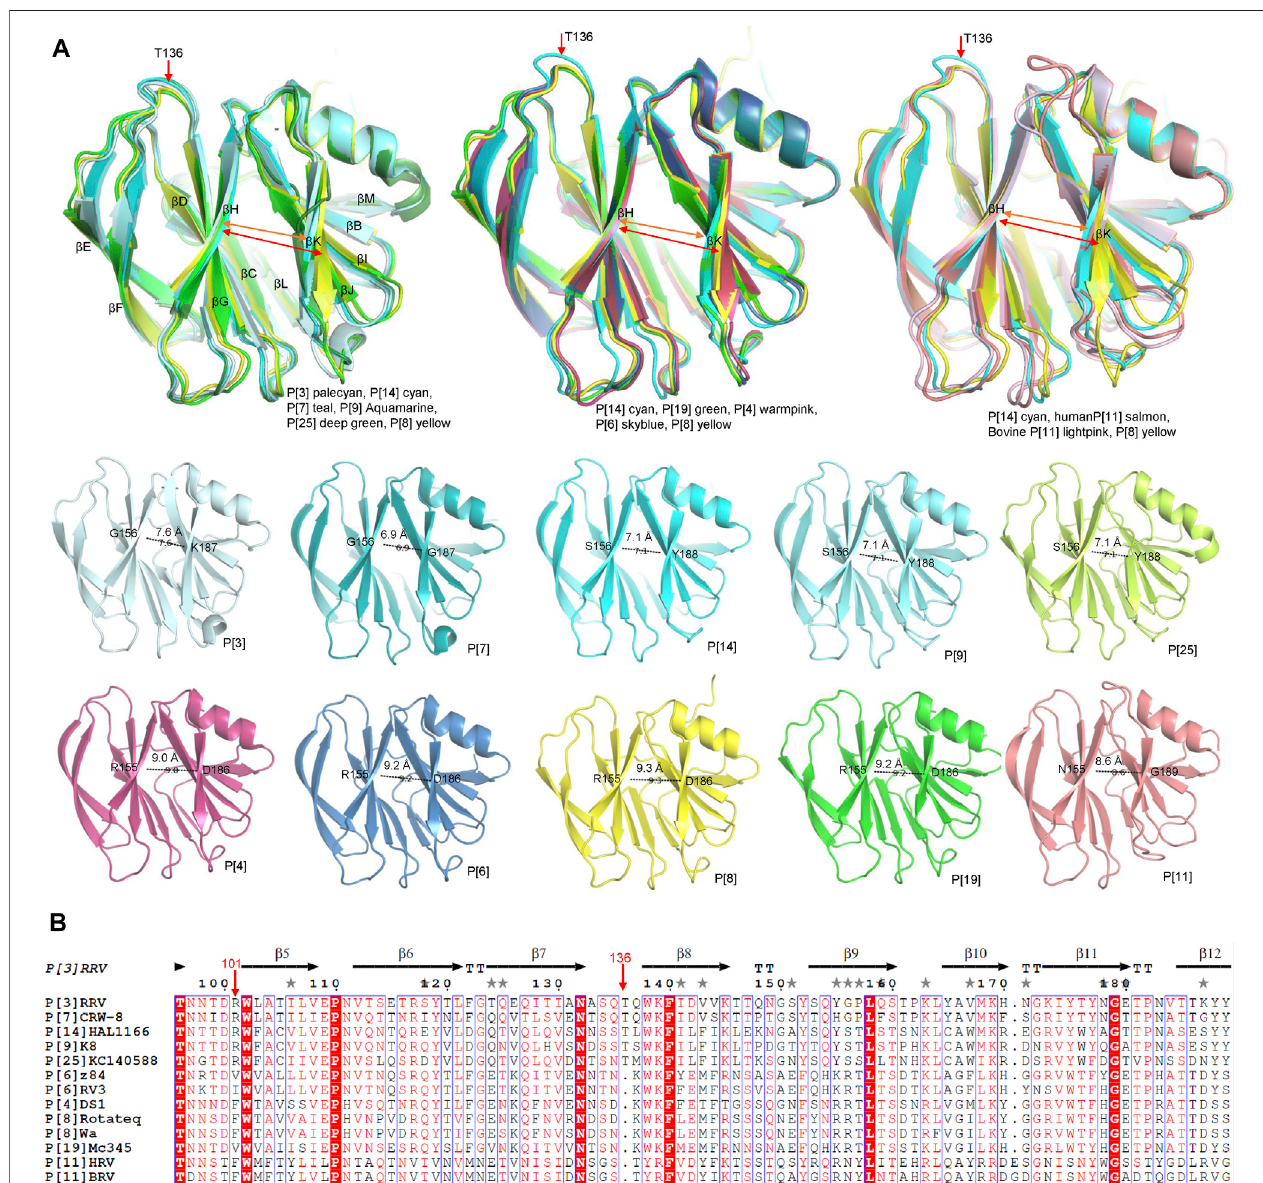
FIGURE 3 | (A) Structural analysis of the VP8* structures. Superimposition of the VP8* structures to compare the width of the cleft between two β -sheets ( β H and β K).Thewidth ofthecleftinVP8*sofdifferentPgenotype aremeasured.P[3],P[7],P[9],P[14],P[11],P[19],P[4],P[6],P[8]VP8*sarecoloredasdescribed in Figure.2A andP[25]iscoloreddeepgreen(PDBID:7C8P). (B) ThestructuralbasedsequencealignmentwasconstructedusingClustalOmegaanddisplayedwiththeESPript3.0 (https://espript.ibcp.fr/ESPript/cgi-bin/ESPript.cgi). Residue 101 and 136 were pointed with red